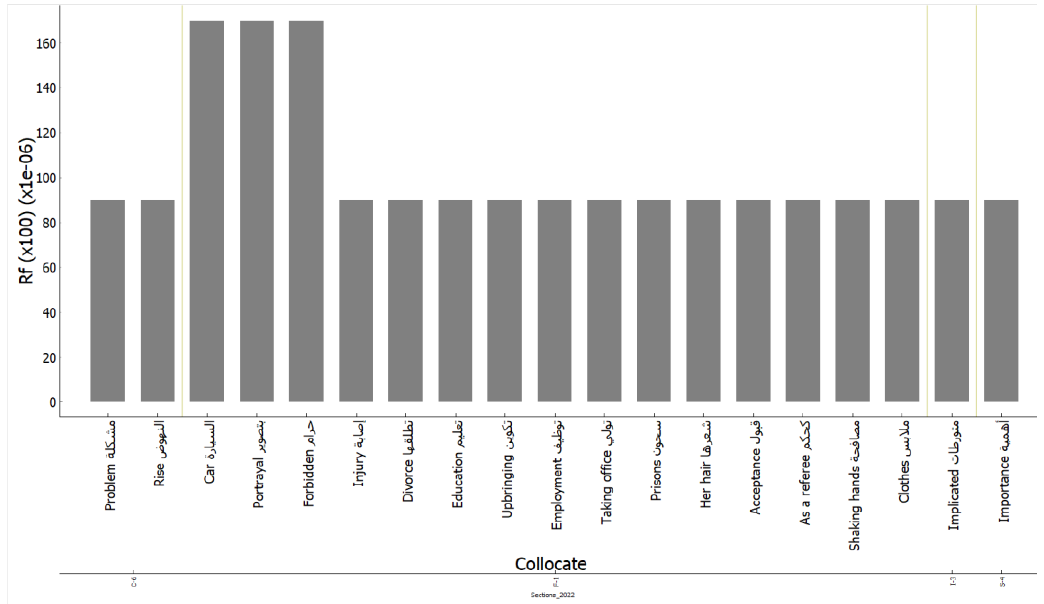
Figure 3. Bar plot of the genitive/adjective construction co-occurrences rf = (>0.000001 × 100) for 2022.